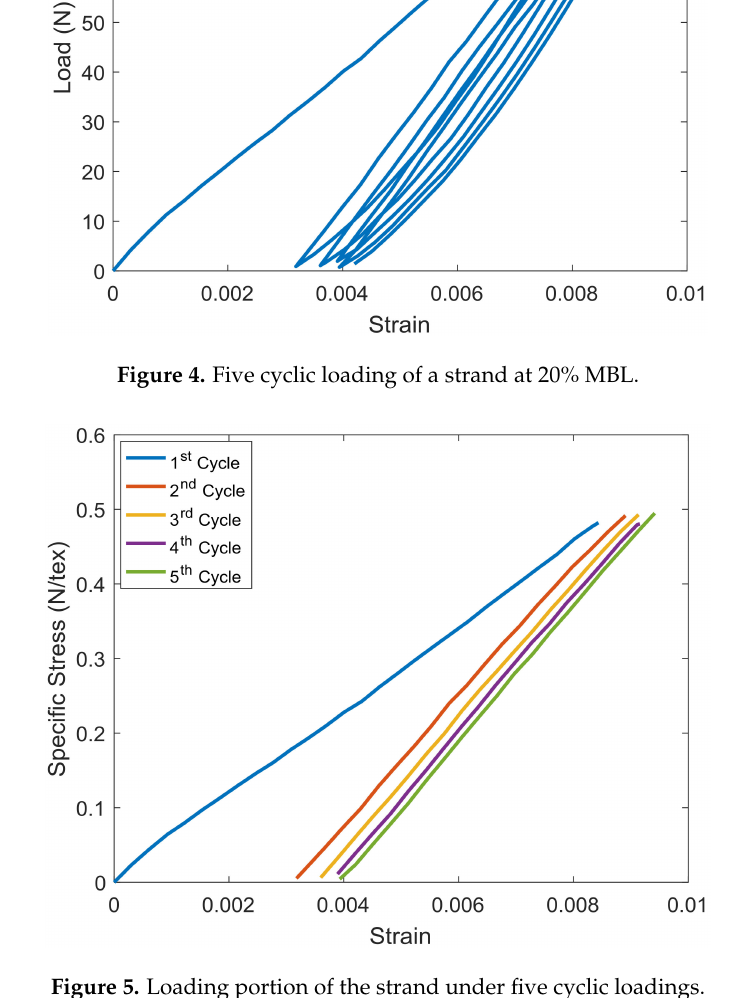
Figure 5. Loading portion of the strand under five cyclic